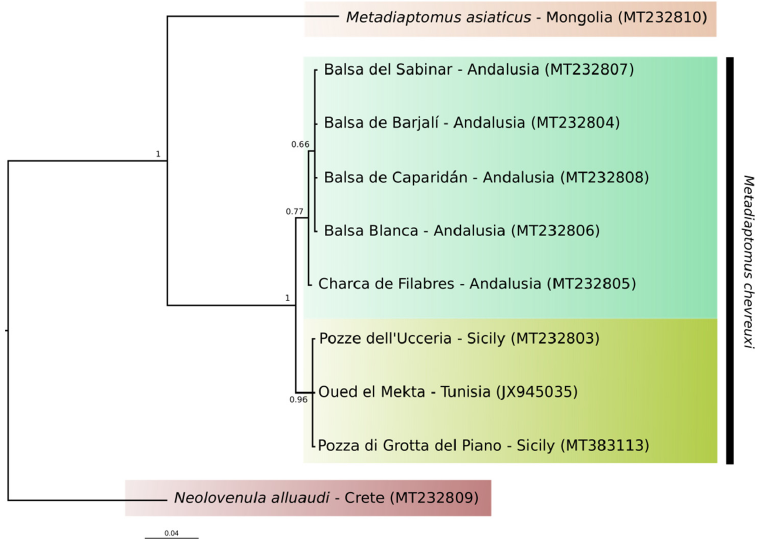
Figure 3. Bayesian phylogram based on a 308-bp long fragment of the mitochondrial gene for the cytochrome b. Node support is reported as nodal posterior probabilities. Accession numbers of both novel and GenBank sequences shown in brackets. The “Andalusian” and the “Sicilian-Tunisian” subclades are reported in different shades of green.